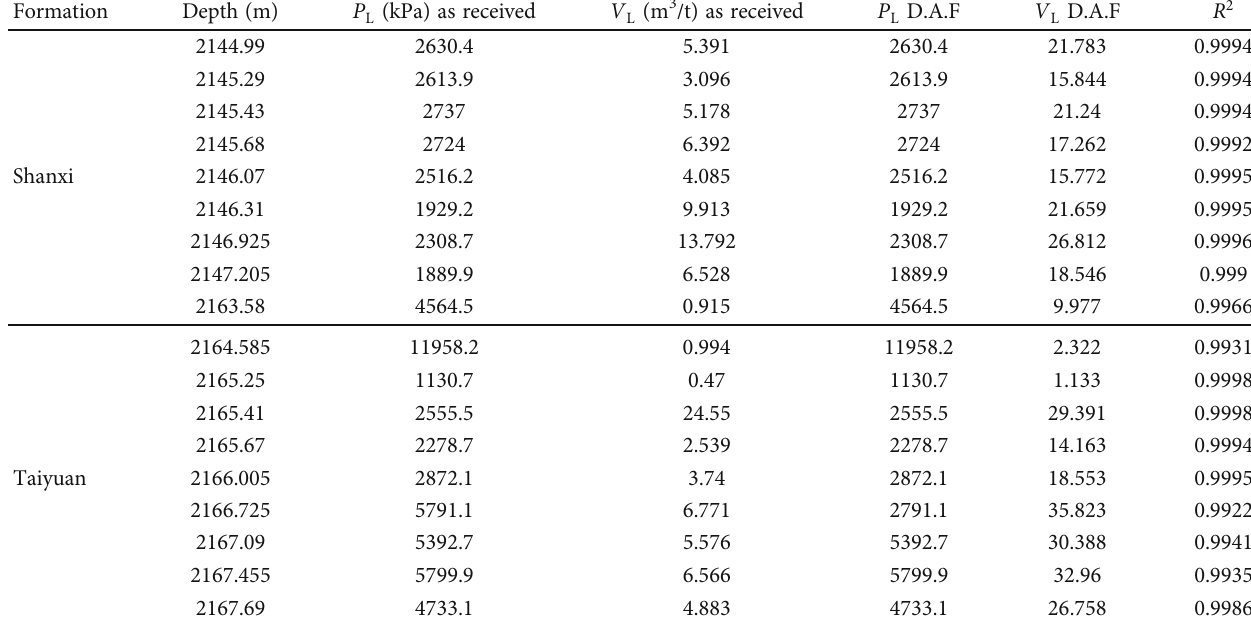
Table 3: Methane gas sorption capacity of the shale samples at 70 ° C from the Lower Permian Shanxi Formation and Taiyuan Formation in the Ordos Basin. Note: V L and P L are the Langmuir volume and pressure at which the sorbed methane gas volume reached half of P L . R 2 =correlation coe ffi cient; D.A.F=dry